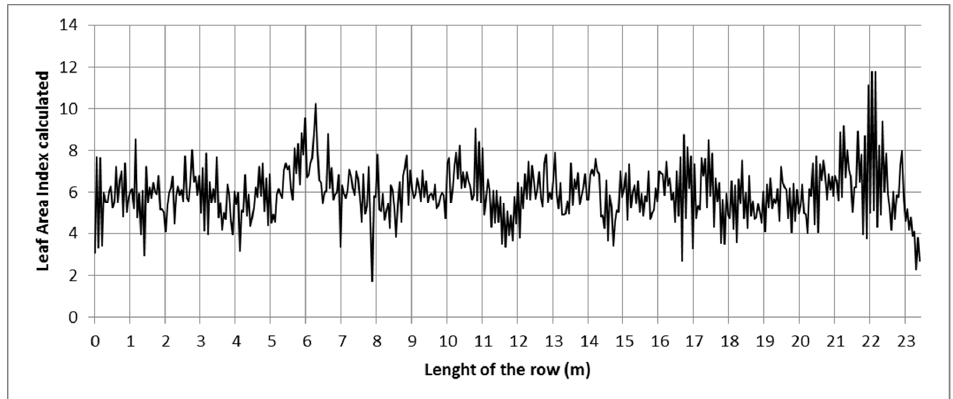
Figure 6. Calculated LAI variation along the scanned row in GH3.